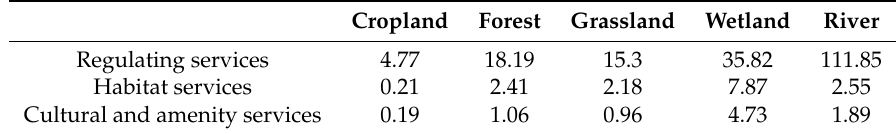
Table 4. The equivalent coe ffi cient for ecosystem services value (ESV) per unit area of ecosystem services for each land use and ecosystem